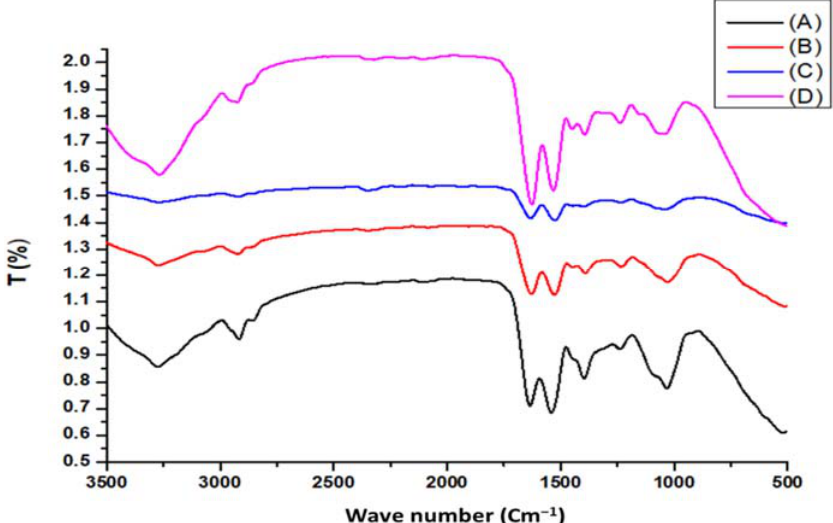
Figure 1. FTIR spectra for (A) ACDW before treatment, (B) ACDW after treatment, (C) LFB before adsorption, and (D) LFB after adsorption of ammonia.